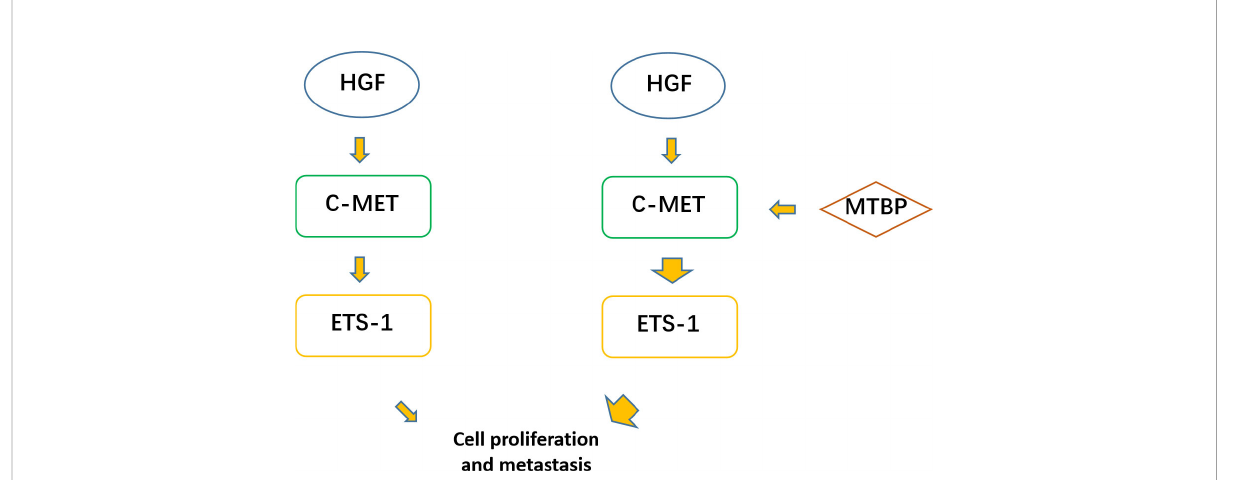
FIGURE 11 MTBP effects on ETS-1. ETS-1 is a downstream effector (transcription factor) of HGF/c-MET, and HGF can fi nally activate ETS-1 through activation of c-MET. ETS-1 can promote the proliferation of malignant tumor cells such as HCC by mediating the expression of its downstream genes. MTBP can act as a transcriptional activation cofactor (coactivator) of ETS-1, upregulate the activity of HGF/c-MET/ETS-1 pathway, and ultimately promote the proliferation of HCC cells.